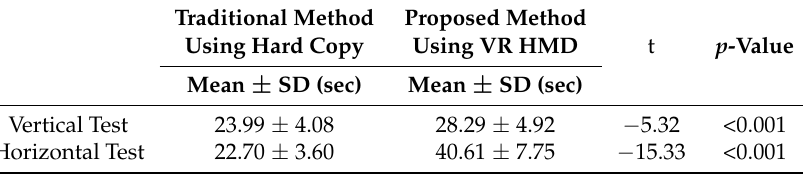
Figure 5. Chart comparisons of the subjective symptom scores (* stands for the items which showed a significant difference between the two tests.): ( a ) Symptom scores for Questions 1.1–1.5; ( b ) Symptom scores for Questions 2.1–2.7; ( c ) Symptom scores for Questions 3.1–3.9; ( d ) Symptom scores for Questions 4.1–4.4. Table 5. A comparison of the adjusted times.